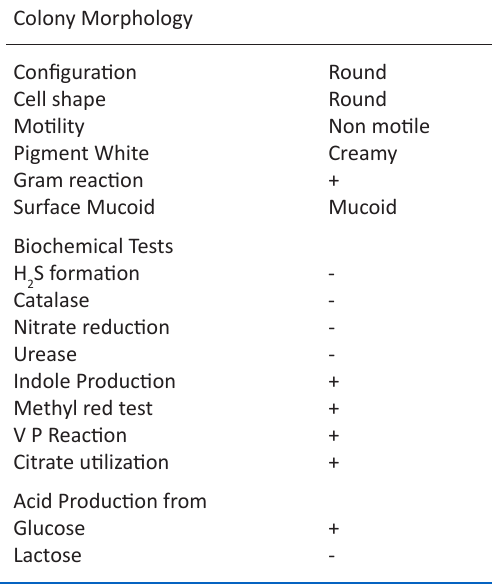
Table 2. Morphological and biochemical properties of the